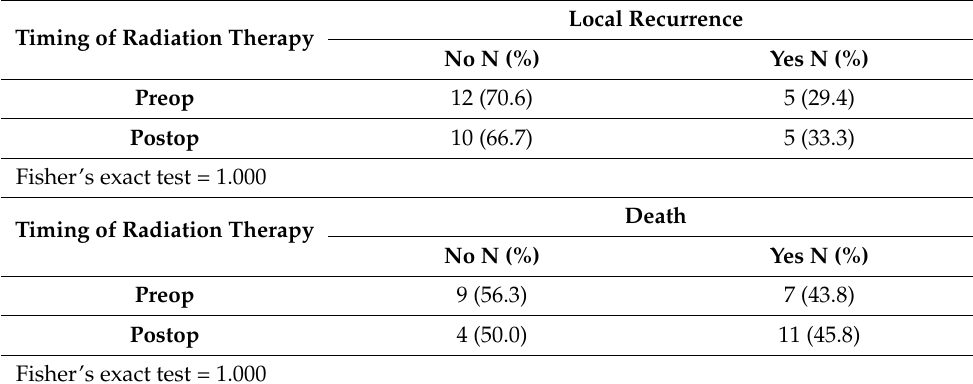
Table 5. Local recurrence and overall survival rate in relation to the timing of radiation therapy. Timing of Radiation Therapy